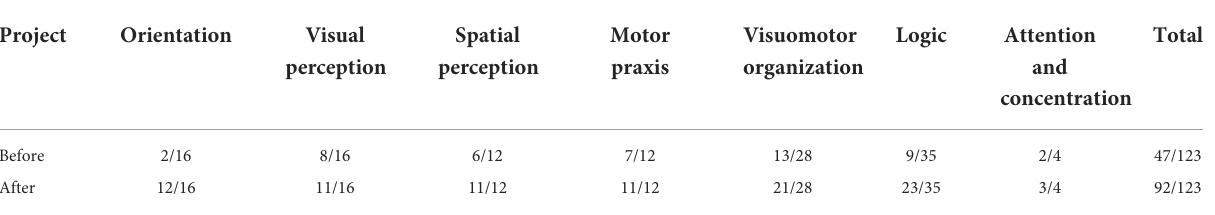
TABLE 2 The assessment results of